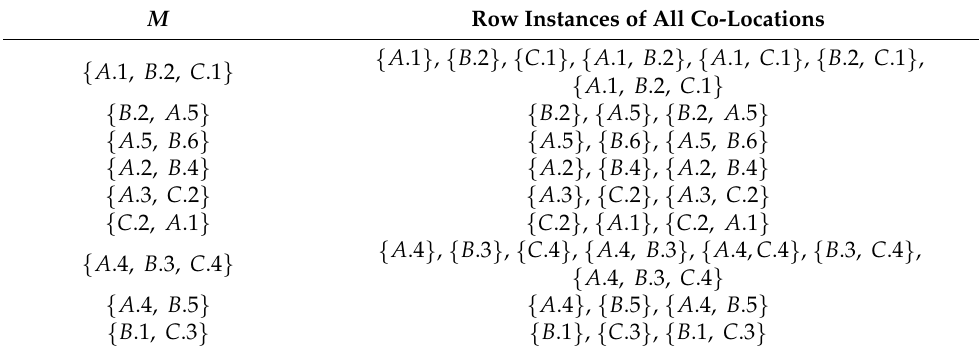
Table 1. Enumeration of the maximal instance and co-location instances. M Row Instances of All